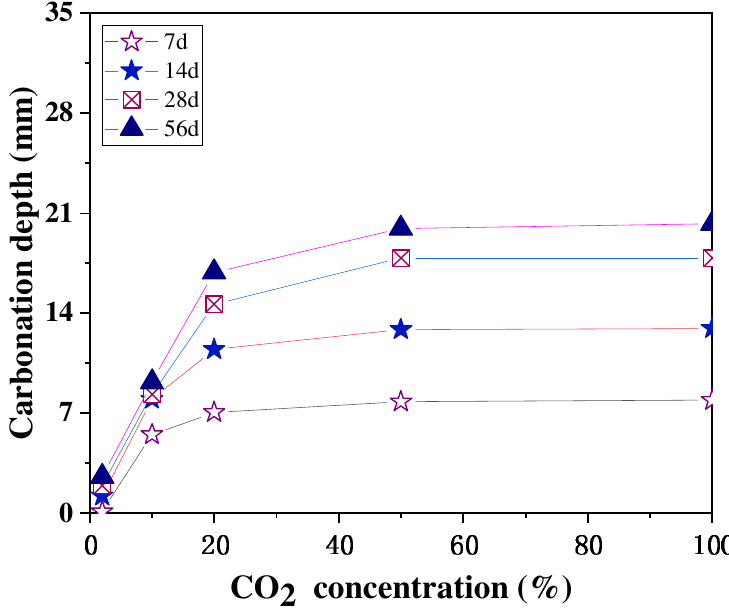
Figure 6. Relationship between CO 2 concentration and carbonation depth [47].